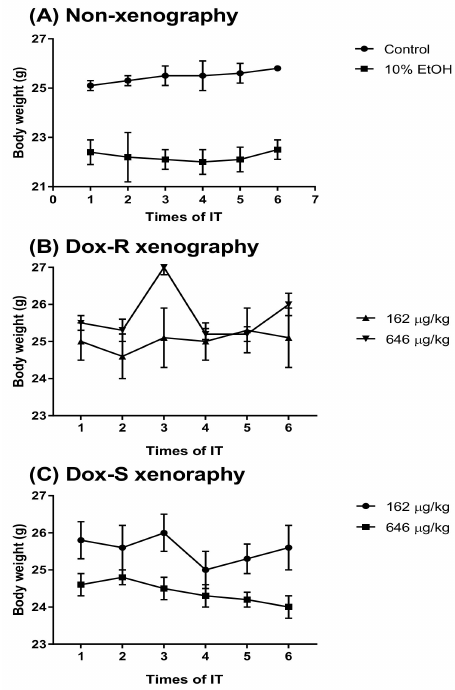
Figure 7. The body weight of the Dox-R and Dox-S xenograft mice during treatment with PG. ( A ) Non-xenograft, ( B ) Dox-R xenograft, and ( C ) Dox-S xenograft mice treatment with PG (162 and 646 µ g/kg B. wt) or 10% EOH by intra-tracheal (IT) injection once every 5 days and measured body weight at each time of IT injection. Results were represented as mean ± SD of 6 mice in each